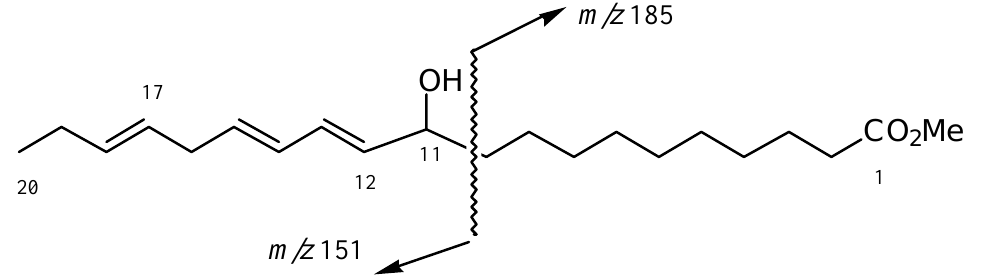
Figure 2. MS fragmentation pattern of compound 1